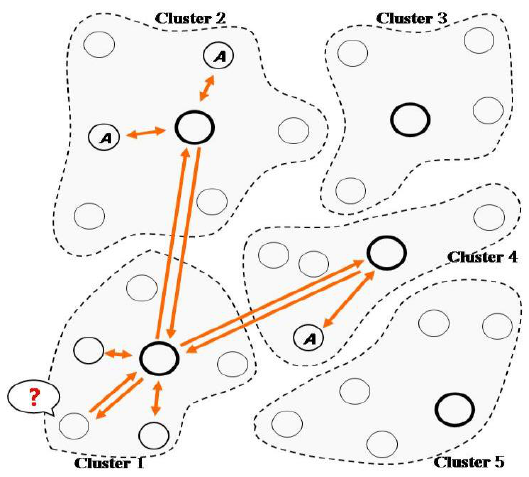
Figure 1. Cluster configuration with properties of things ( : Cluster header, A: Air state monitoring node, ?: Query node, : Message).